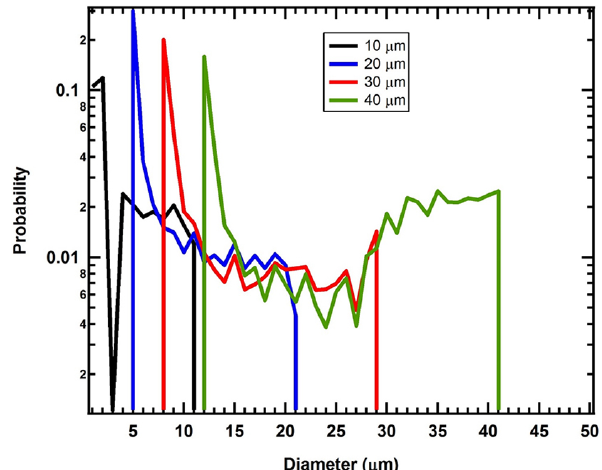
Figure 6. This figure illustrates the theoretical probability distribu- tions for droplets with four different diameters. The probabilities are that a particle with the given size will be measured as a particle with a smaller